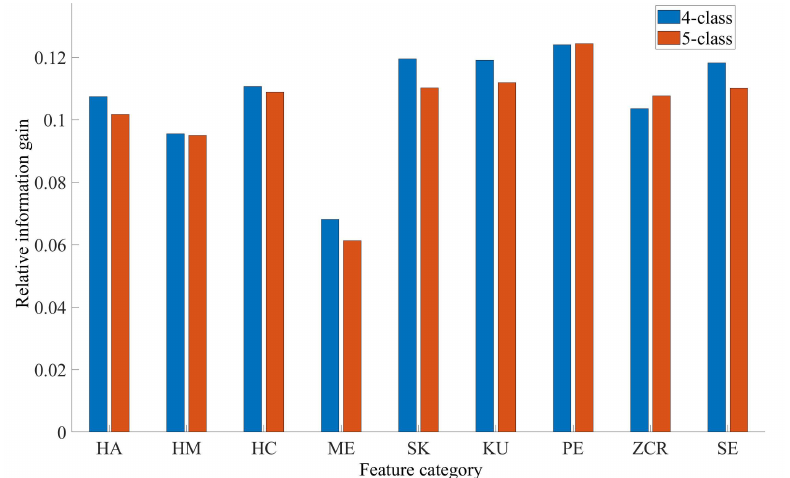
Figure 6. Relative information gain of Sleep-EDF database features in the XGBOOST model.